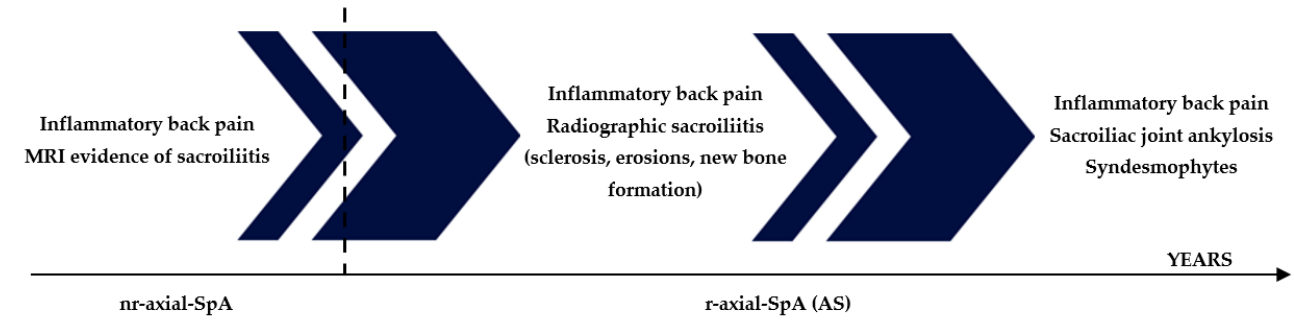
Figure 1. Axial-SpA may evolve over time, from an early phase without radiologically detectable changes in the pelvic X-ray (nr-axial-SpA) toward a late phase in which structural changes such as sclerosis, erosions, and new bone formation in the sacroiliac joints and in the spine occur (r-axial-